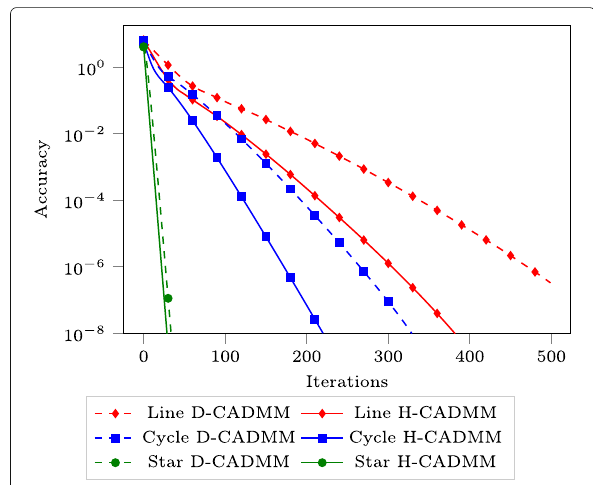
Fig. 6 Effects of in-network acceleration on the line graph, the cycle graph, and the star graph